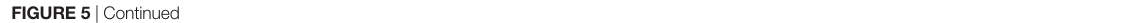
FigUre 5 | Continued Anergic CD4 T-cells are suppressive toward autologous responsive counterparts. CD4 T-cells taken from animals’ 2 weeks of postinfection were cocultured with autologous CD4 T-cells isolated from the hepatic lymph node at postmortem. (a) Proliferation in response to LFH is still detectable in week 2 CD4 T-cells, as per previous findings; however, when anergic week 13 CD4 cells are added at a ratio of five cells per 1 week 2 responder cells, we see a strong suppression of